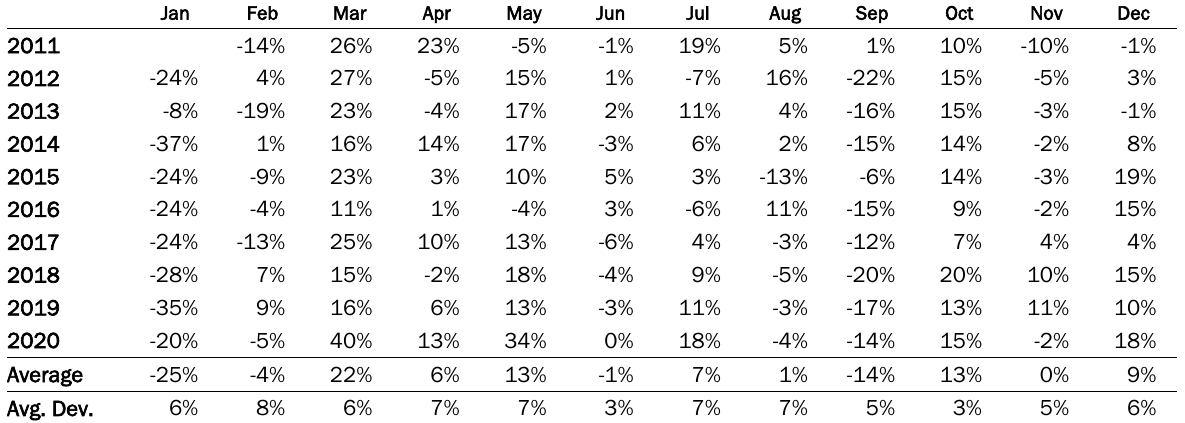
Table 2. Change in Food Sales from the Previous Month, Averaged 2011 – 2020